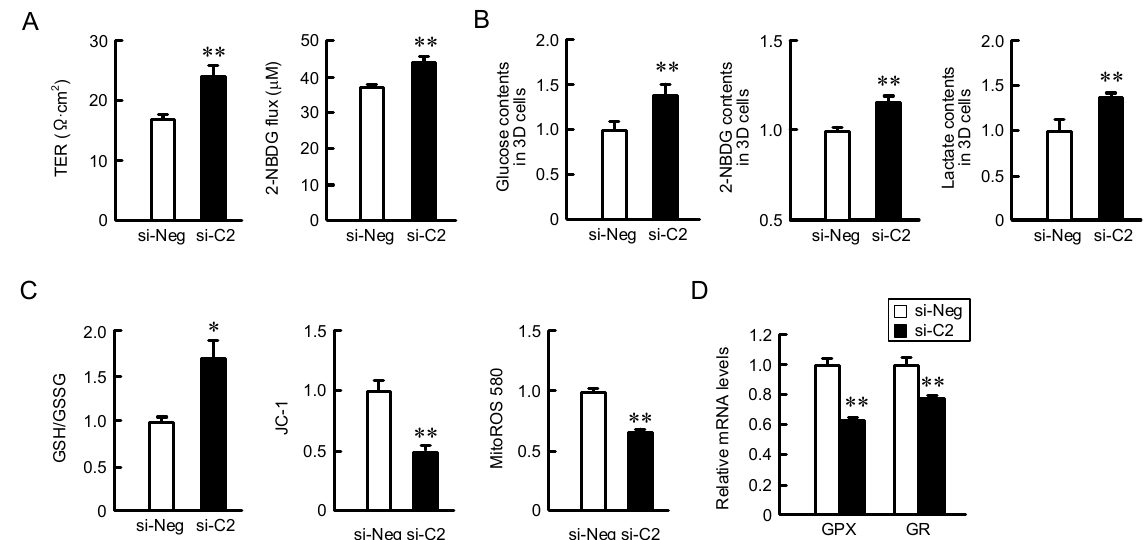
Figure 7. Effect of CLDN2 knockdown on paracellular permeability in 2D monolayer and accumulation in 3D spheroids against small molecules. ( A ) A549 cells transfected with negative (si ‐ Neg) or CLDN2 siRNA (si ‐ C2) were cultured on transwell inserts for 4 days. TER was measured using volt ohmmeter. 100 μ M 2 ‐ NBDG was added on transwell inserts. After incubation at 4 °C for 60 min, the fluorescence intensity in the lower solution was measured using an Infinite F200 PRO microplate reader. ( B ) A549 cells transfected with si ‐ Neg or si ‐ C2 were cultured on 96 ‐ well round ‐ bottomed plates for 4 days. The contents of glucose, 2 ‐ NBDG, and lactate were measured using each assay kit and represented to the values in si ‐ Neg. ( C ) A549 cells transfected with si ‐ Neg or si ‐ C2 were cultured on 96 ‐ well round ‐ bottomed plates for 4 days. The glutathione redox state was measured using a Kit. The mitochondrial potential and ROS production were examined using JC ‐ 1 and MitoROS 580, respectively. The values in si ‐ C2 are represented relative to the values in si ‐ Neg. ( D ) A549 cells transfected with si ‐ Neg or si ‐ C2 were cultured on 96 ‐ well round ‐ bottomed plates for 4 days. The mRNA levels are represented relative to the values in si ‐ Neg. n = 3–4. ** p < 0.01 and * p < 0.05 compared with si ‐ Neg.